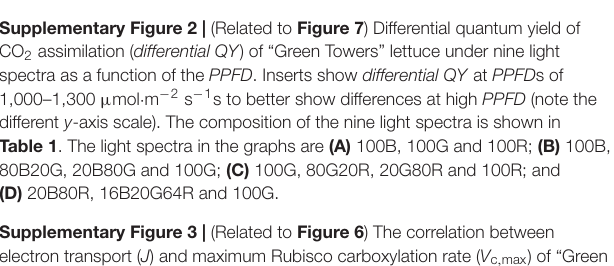
Supplementary Figure 3 | (Related to Figure 6 ) The correlation between electron transport ( J ) and maximum Rubisco carboxylation rate ( V c , max ) of “Green Towers” lettuce estimated from A/C i curves under PPFD (1000 µ mol m − 2 s − 1 ) under nine light spectra ( p <